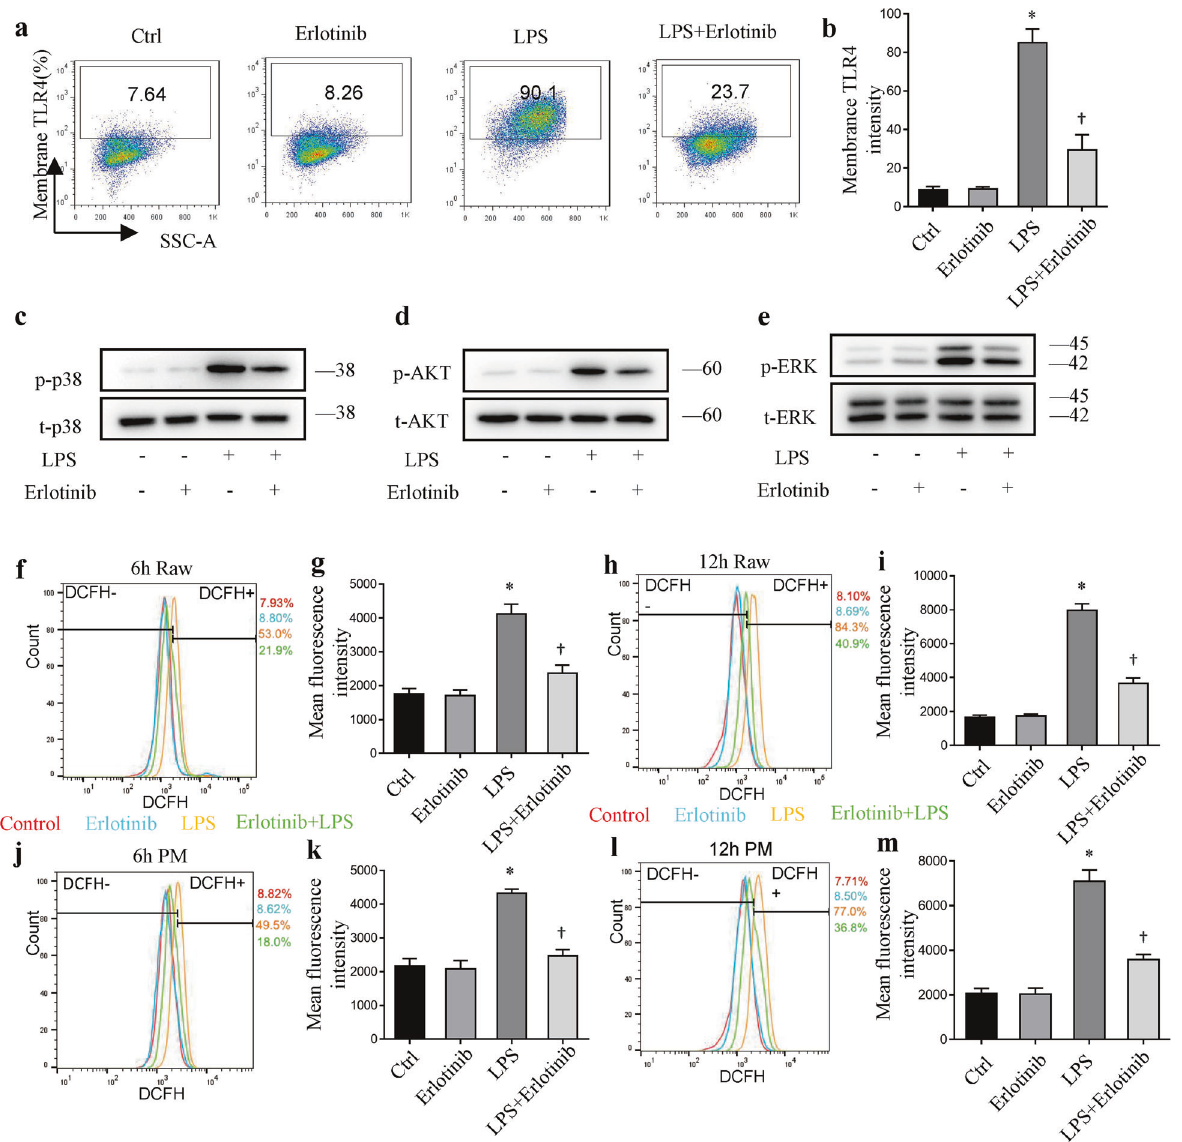
Fig. 4 Cell surface TLR4 expression in response to LPS could be inhibited by erlotinib. a , b Cell surface TLR4 expression in RAW264.7 cells was analyzed by fl ow cytometry. c – e Immunoblot analysis of p-p38, t-p38, p-ERK1/2, t-ERK1/2, p-AKT, t-AKT in RAW264.7 cells treated with LPS for 3 h with or without erlotinib pretreatment for 30 min. f , h , j , l ROS production was measured with DCFH2-DA by FACS analysis. g , i , k , m Mean fl uorescence intensity of ROS production. Error bars represent SD ( n = 3). * P < 0.05 as compared with NC; † P < 0.05 as compared with LPS